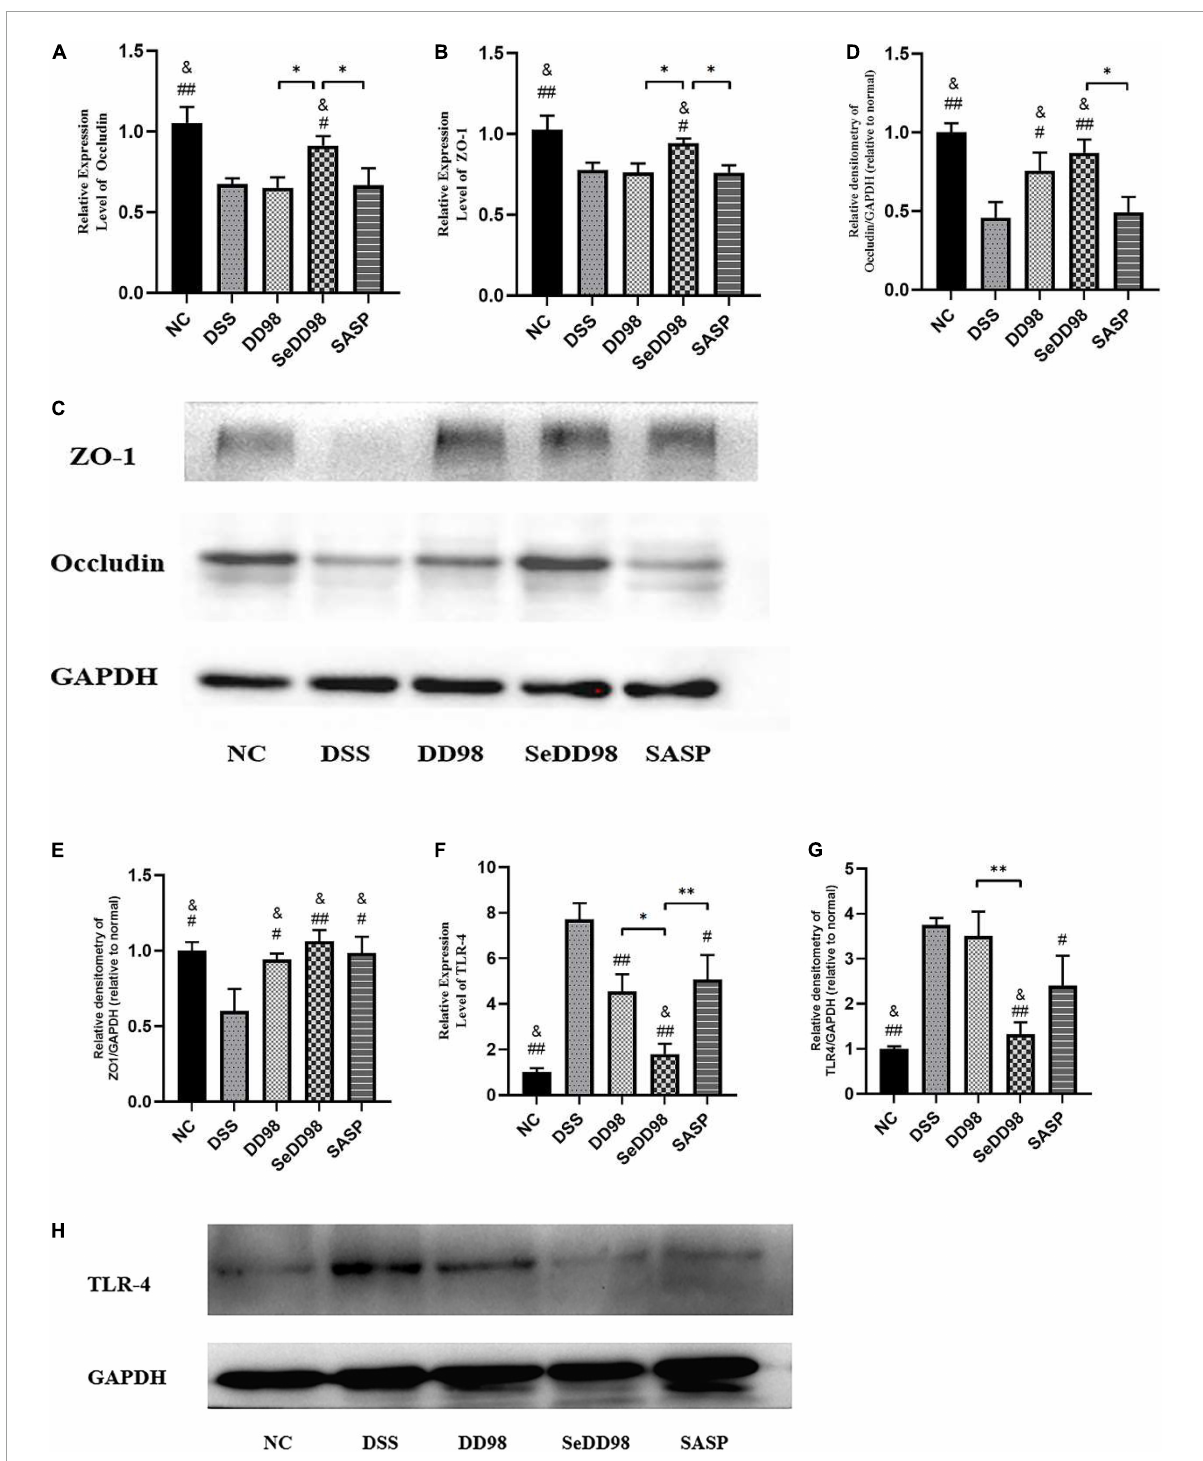
FIGURE5 The impact of Se- B. longum DD98 on intestinal barrier function in DSS-treated mice. (A,B) Occludin and ZO-1 mRNA expression levels were assessed via RT-qPCR ( n = 6). (C–E) Occludin and ZO-1 levels in colon tissues were assessed via western blotting ( n = 3). (F) TLR4 mRNA expression level was assessed via RT-qPCR ( n = 6). (G,H) TLR4 level in colon tissues was assessed via western blotting ( n = 3). Data are shown as the mean ± SEM. ∗ p < 0.05, ∗∗ p < 0.01. # p < 0.05 compared to DSS group. ## p < 0.01 compared to DSS group. & p > 0.05 compared to the NC group by one-way